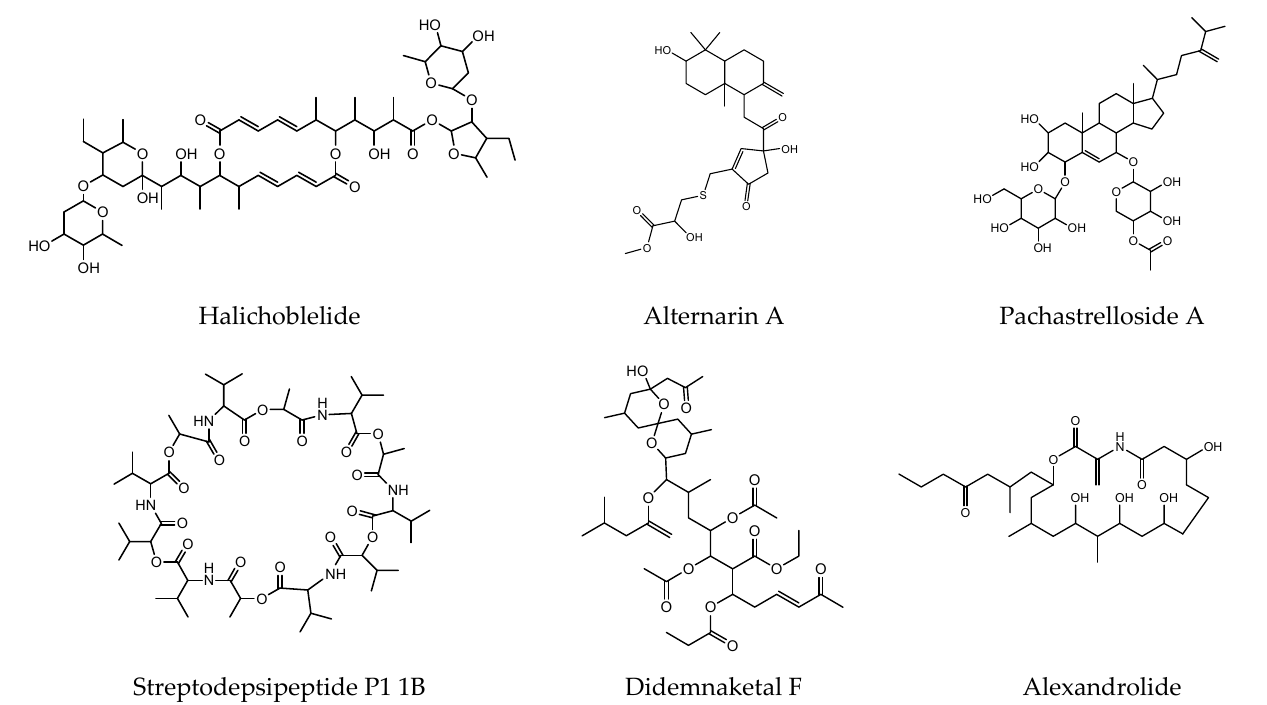
Figure 4. Dereplicated metabolites of Streptomyces sp. SCSIO 001680. These compounds were predicted from the Marinlit database.